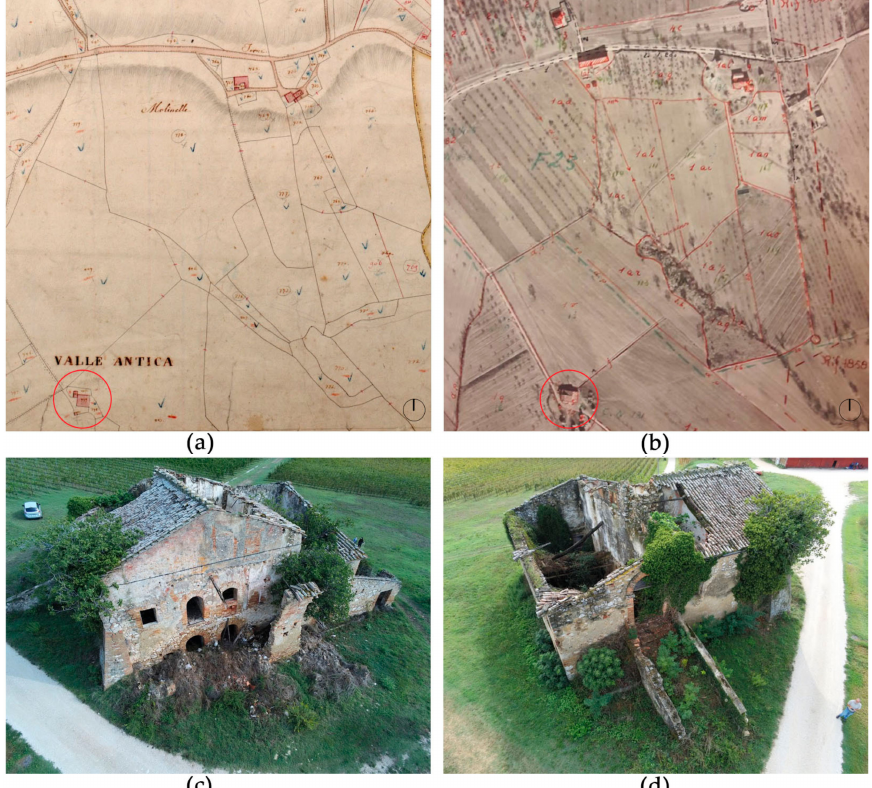
Figure 2. ( a ) Extract from the Gregorian cadaster, 1819. ( b ) Enlarged extract of an aerial photo, scale 1:20.000, from 1940, taken from the archive of the Italian Air Force. ( c , d ) Photographic views of the building.